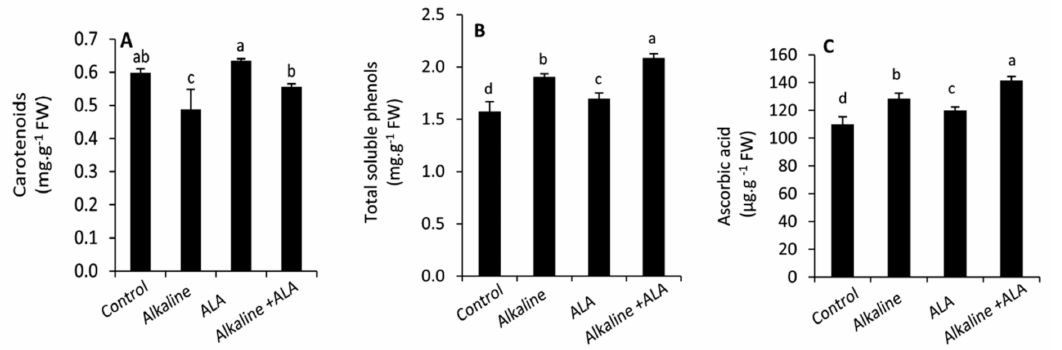
Figure 4. Effect of exogenous α -lipoic acid (ALA; 20 µ M) on the concentration of carotenoids ( A ) total soluble phenols ( B ) and ascorbic acid ( C ) in the leaves of wheat seedlings grown under sodic alkaline